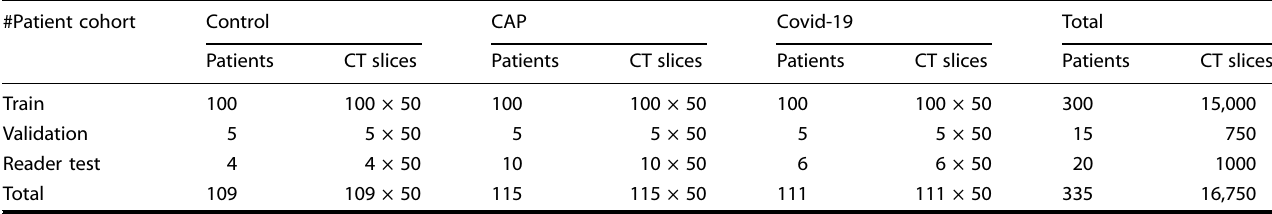
Table 2. Detail information of the samples in multiple steps of analysis (preprocessing, train, validation, and test